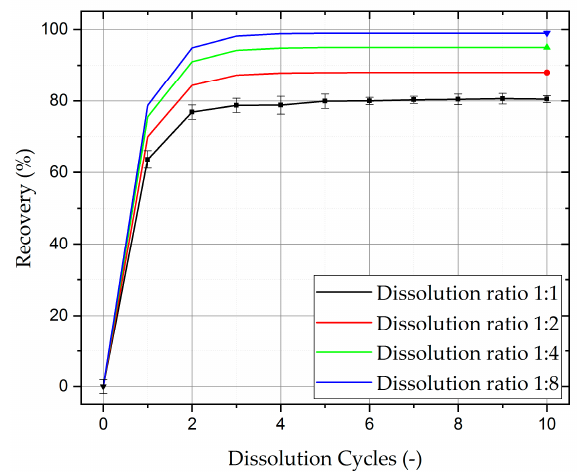
Figure 13. Recovery of mAb during dissolution. One dissolution cycle means that the full volume of the dissolution buffer passed through the experimental setup. The buffer was recycled to enhance dwell time with a constant volume ratio of feed and dissolution buffer.